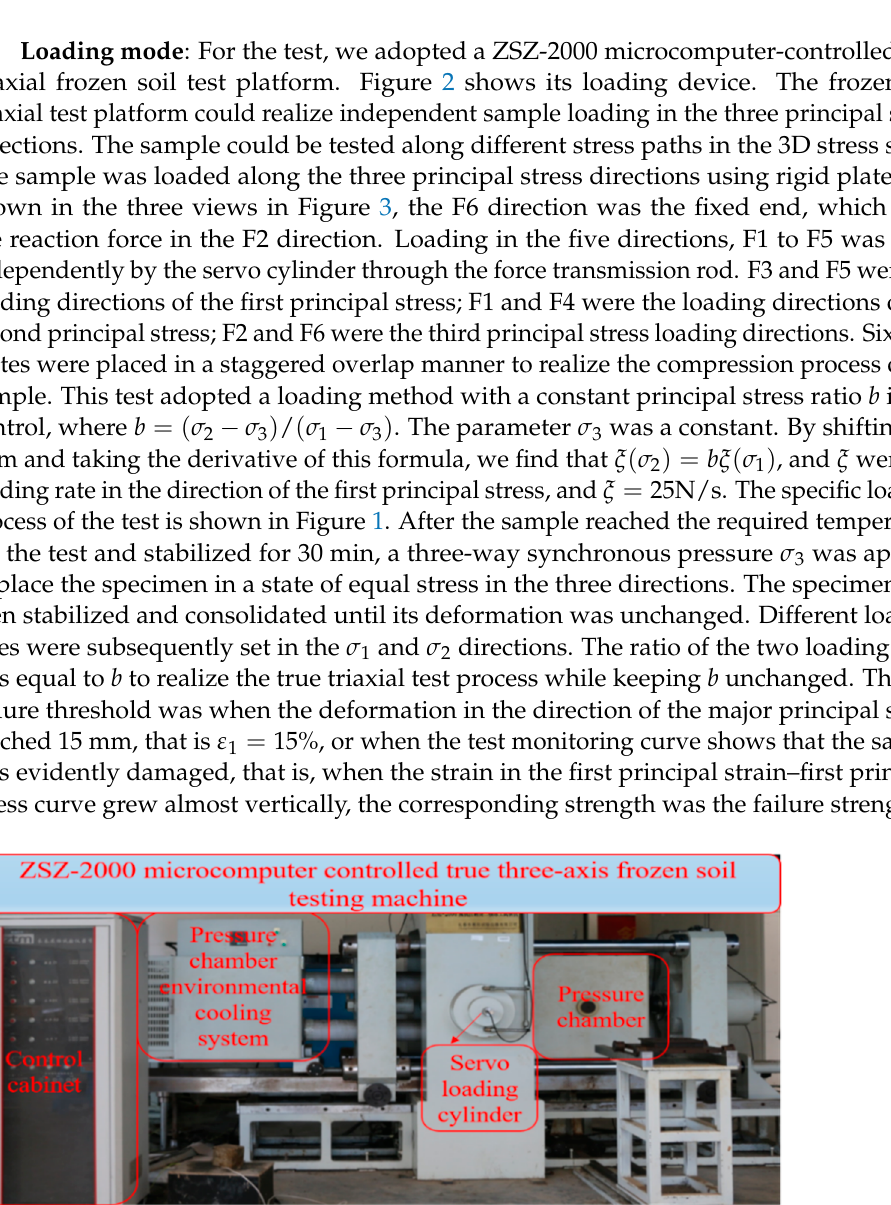
Figure 1. Test loading method.